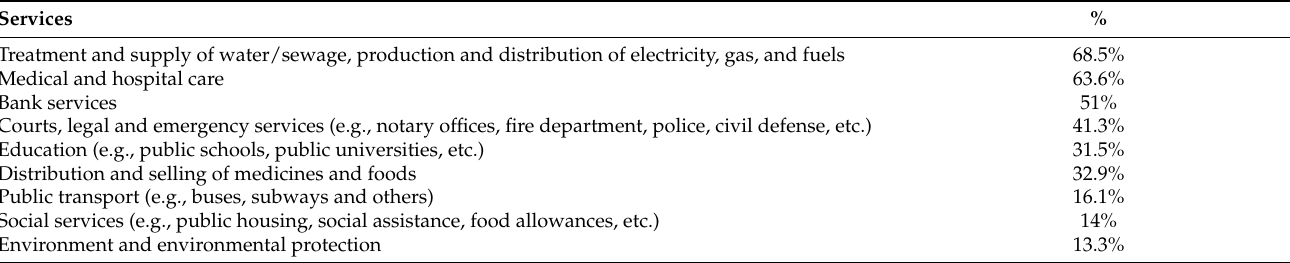
Table 5. Government services used by older